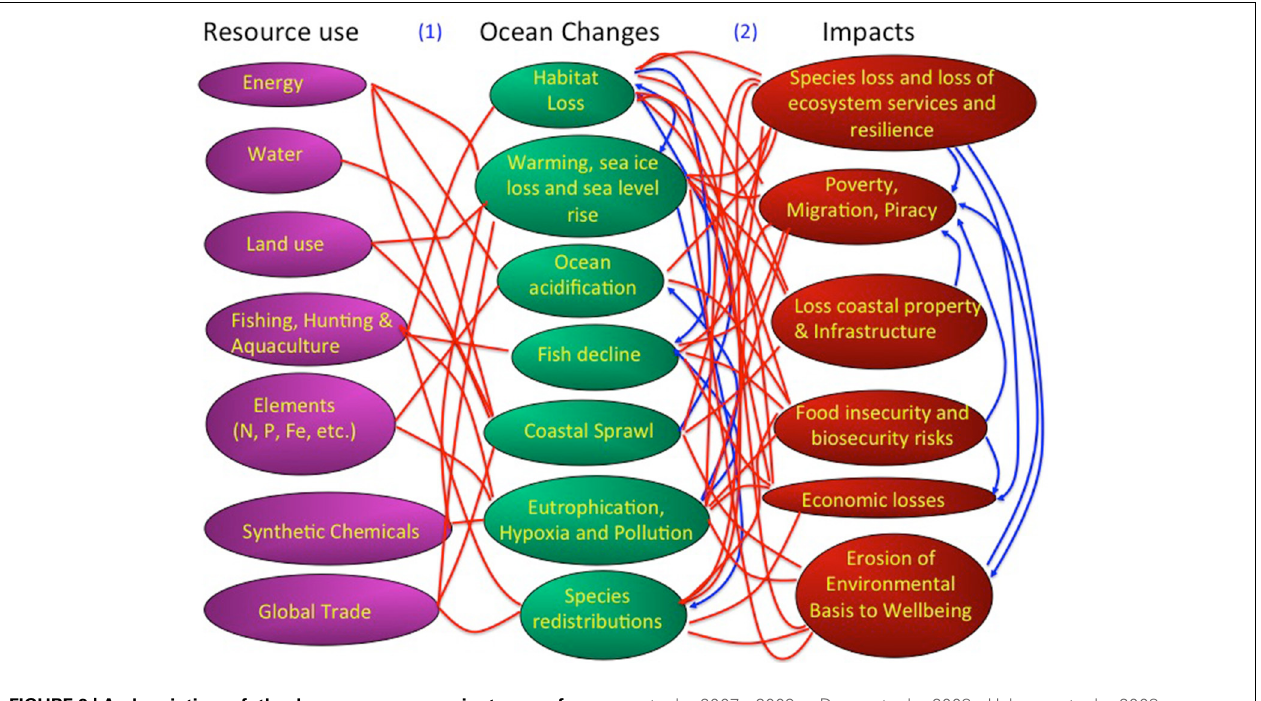
FIGURE 3 | A description of the human pressures, in terms of resource use, oceans changes, and impacts conforming the global change syndrome as affecting the ocean. Red lines indicate links between these components and blue lines denote feedback effects. For a discussion of these links and feedbacks see: (1) Pressures to Ocean Change: (Pauly et al., 1998;